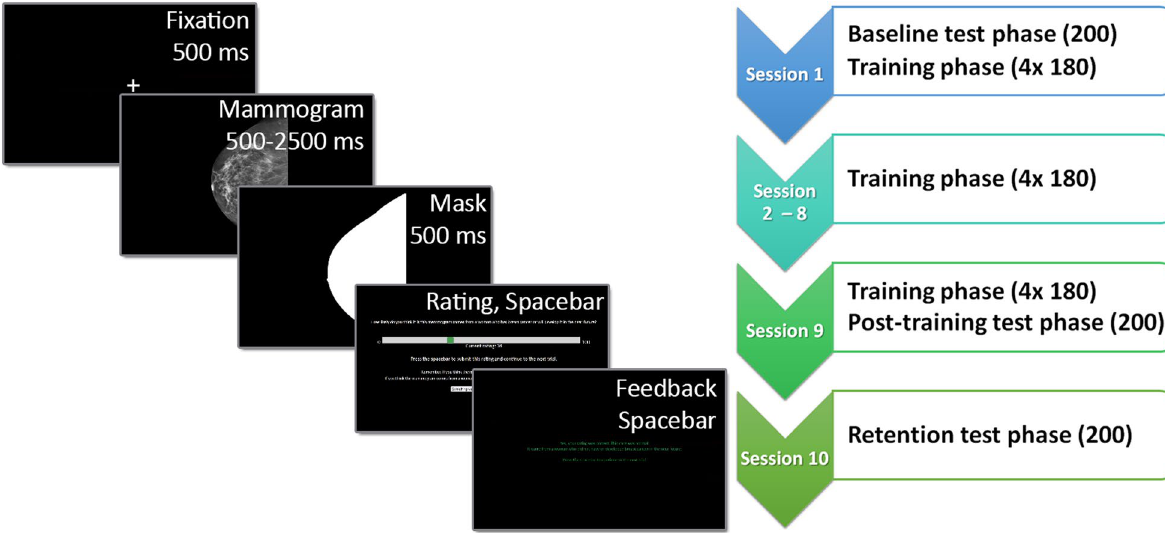
Fig. 2 Overview of the experimental procedure and flow chart schedule of the experiment. The screens show the presentation order within a training trial and the duration or button press to continue. Test trials always showed mammograms for 500 ms and omitted the feedback screen but were otherwise identical. The flow chart schedule shows the order of experimental phases for each session, and the number of unilateral mammograms viewed per session. In the test phases, 200 mammograms were viewed, while the training phases had 4 blocks with 180 mammograms each. Sessions 1 to 9 were separated by 1 to 3 days each, while session 10 was delayed by 7 to 10 days after session